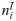

Left: Illustration of the network structure in its most general form, as used in the description of the learning algorithm. Every model unit n
i can excite, inhibit or modulate the activity of any other unit n
j (indicated by non-directional black connections). Units niI of the input layer provide input to the network but their activity does not depend on the activity of other units in the network. Right: A model unit (corresponding to a cortical column) can be excited, inhibited or modulated by other cortical columns.